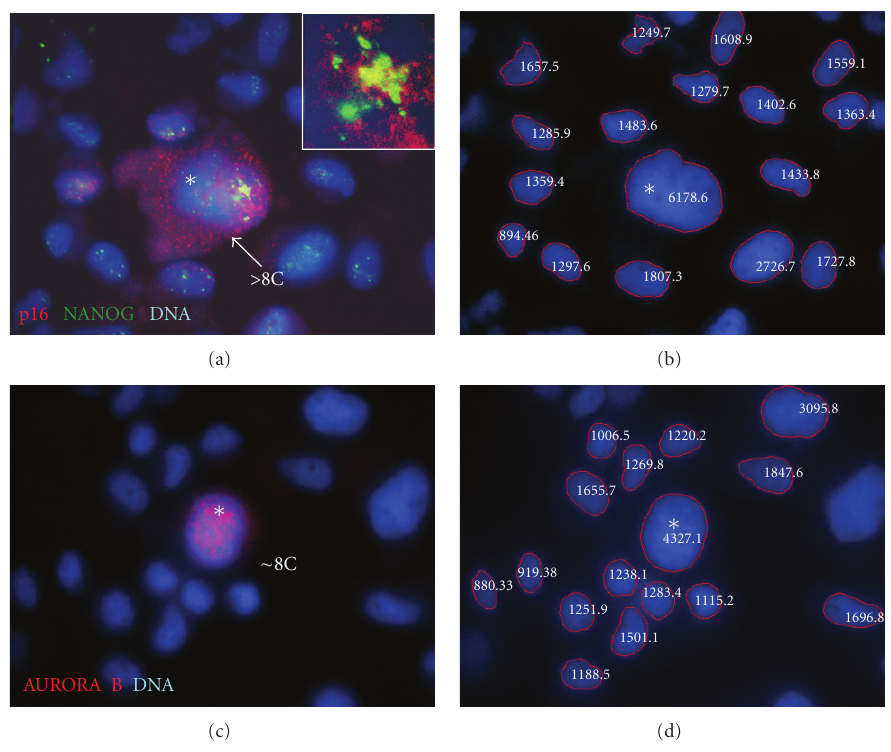
Figure 7: Examples of DNA content measurements by integral fluorescence in the DAPI channel using Image Pro Plus software in microscopic fields including cells with enlarged nuclei and stained for: ((a), (b)) NANOG, p16, and DNA by DAPI, ((c), (d)) Aurora B- kinase and DNA by DAPI. The selected hyperoctoploid cell ( ∗ ) shown in (a) has an enlarged p16-positive cytoplasm and some amount of both NANOG and p16 in the nuclear region, and this region is magnified in the insertion; the paraoctoploid cell in (c) is positive for Aurora